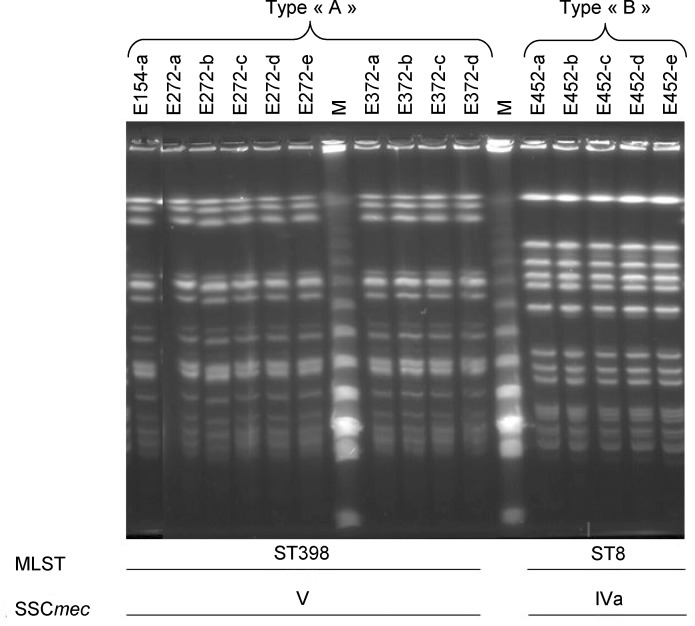
Pulse-field gel electrophoresis following Cfr9I digestion.M: lambda DNA marker, Type “A”: Pulse-field gel type A, Type “B”: Pulse-field gel type B.